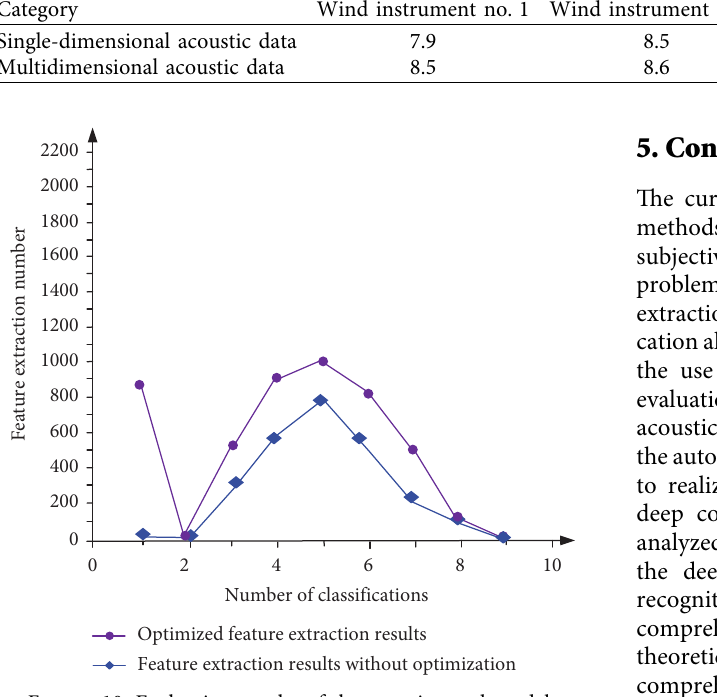
Figure 10: Evaluation results of the experimental model.